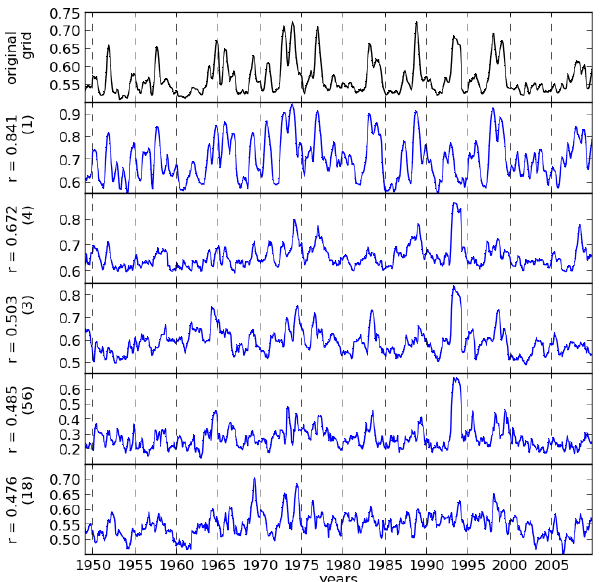
Fig. 3. The temporal evolution of threshold W ∗ for selecting the intra-regional components. Top panel: the temporal evolution of the global 2562-node network threshold. Bottom panel: the temporal evolution of threshold W ∗ for the selected five regions with the most similar evolution to the global graph evolution. For each compo- nent, its identification number and the correlation of the respective time series with the global 2562-node network threshold evolution is shown.